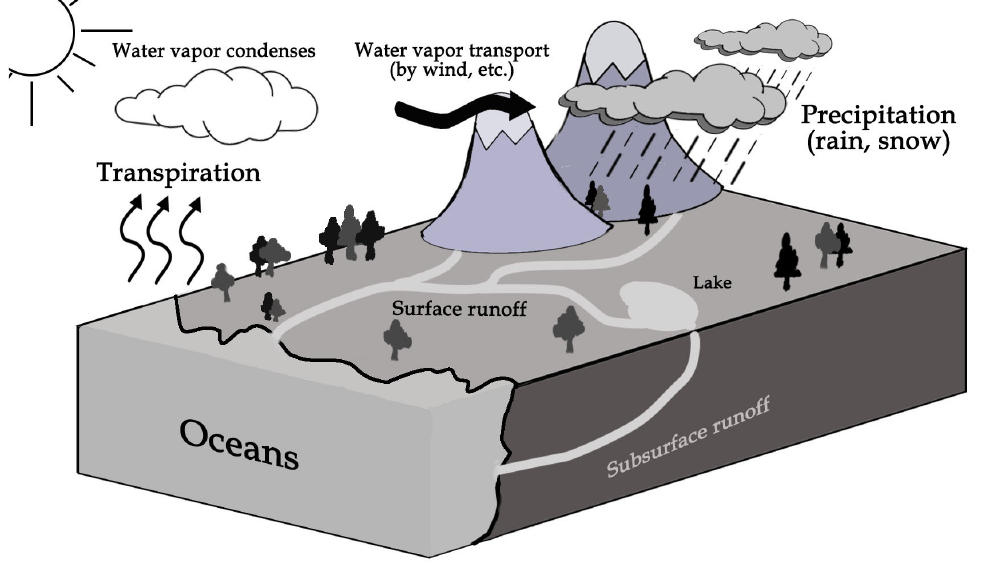
Figure 1. Diagram of the water cycle.